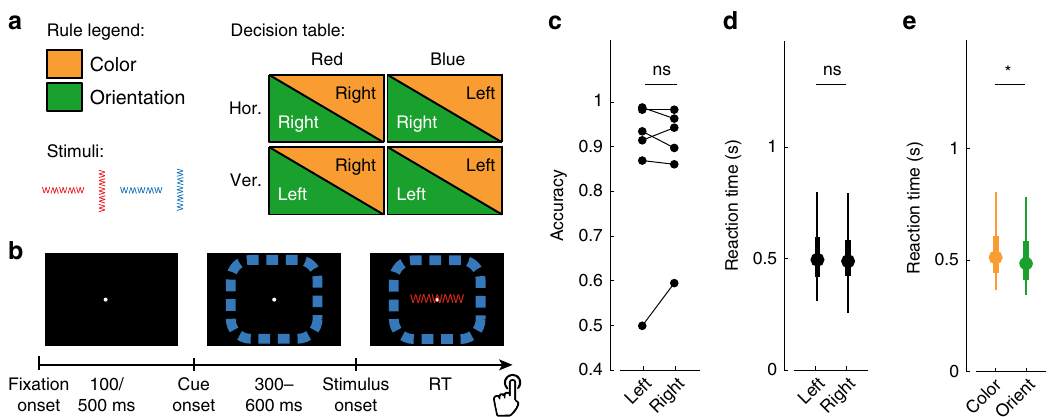
Fig. 1 Task and behavioral performance. a Stimuli and decision table showing the correct button press for each combination of rule and stimulus characteristics; b task sequence and screen layout; c task performance for left and right button presses. Each line connecting two dots represents one subject; d reaction time distributions for left ( N = 1559) and right ( N = 1566) button presses of all subjects combined (see Supplementary Fig. 2 for individual subjects); e reaction time distributions for the color ( N = 1578) and orientation ( N = 1547) rules. The boxplots in d and e show the 5, 25, 50 ( fi lled circles), 75, and 95% boundaries. Gray horizontal bars represent the outcome of two-sided statistical tests of difference, using a paired t -test in c and Student ’ s t -test in d and e . ns means not signi fi cant and * indicates signi fi cance at α = 0.01. Orange: color rule; green: orientation rule. a and b were adapted from ref. 30